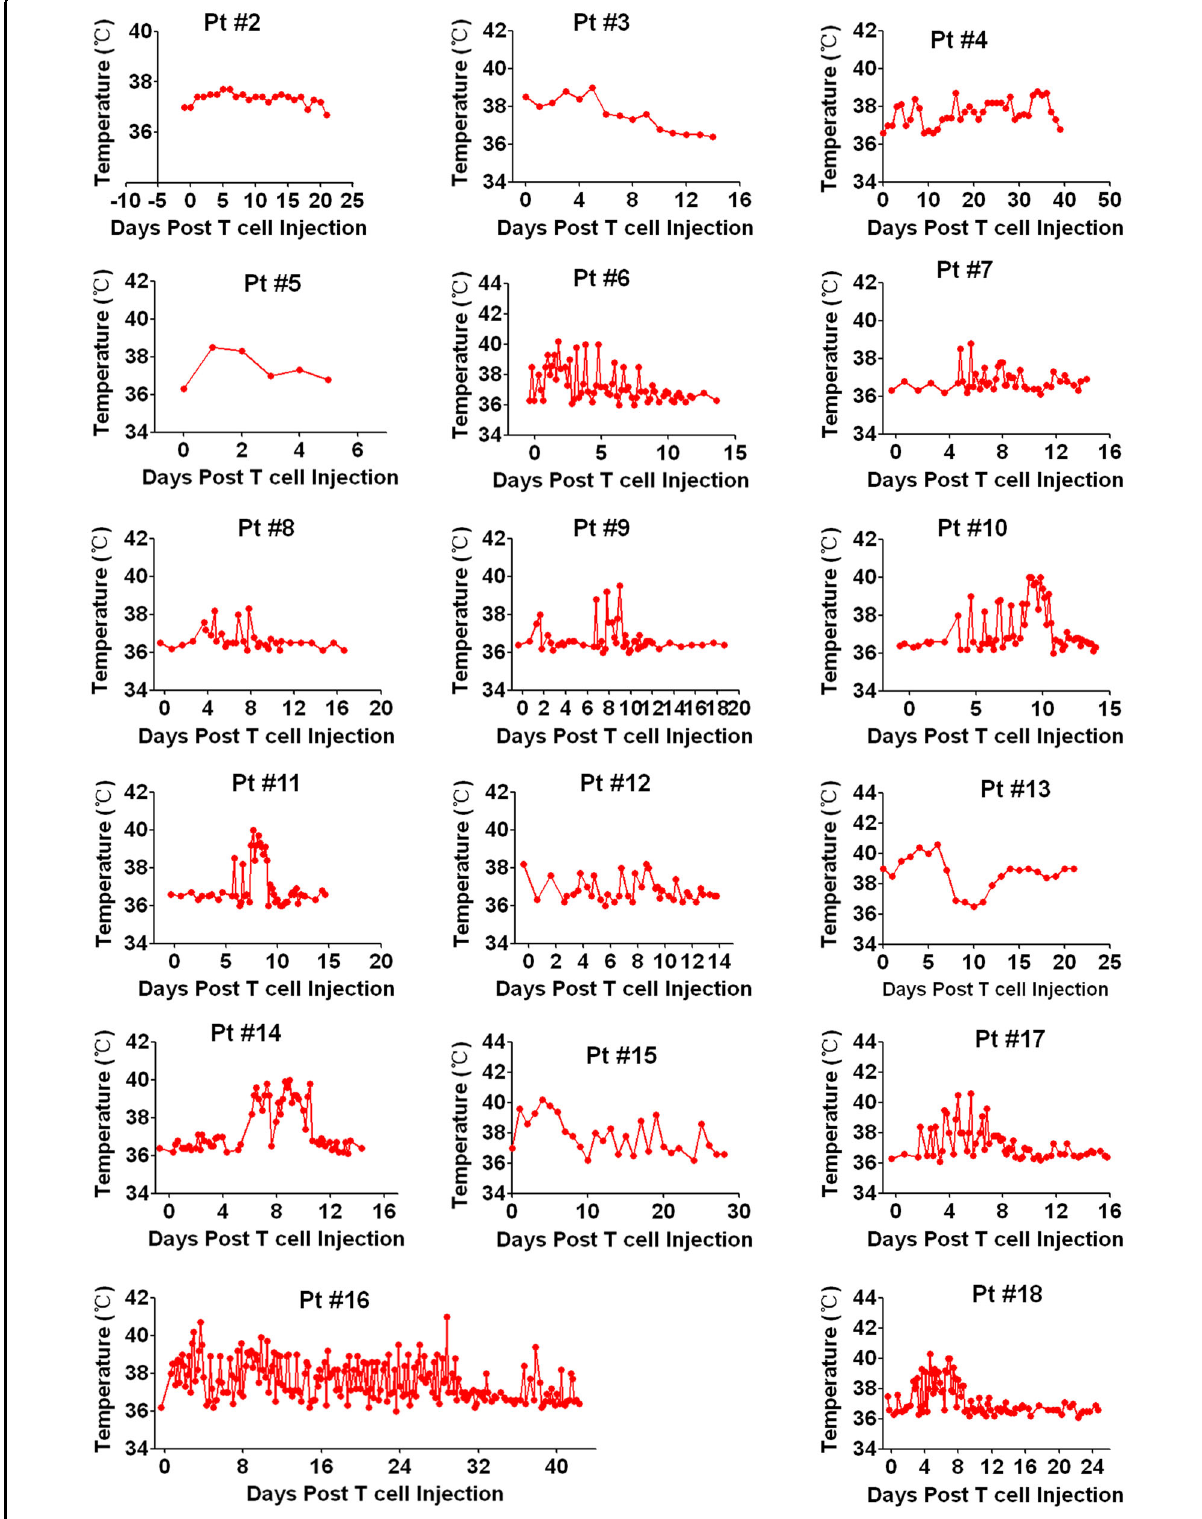
Fig. 3 Changes of body temperature in patients treated with CART-aIL6/IL1RA. Patients (as numbered in Table 1) with refractory or relapsed ALL, CLL, Lymphoma, or MM were enrolled and treated with anti-CD19 or anti-BCMA CART secreting anti-IL6 scFv and IL1RA. After CART infusion, patients were monitored for recording body temperature to assess grading of